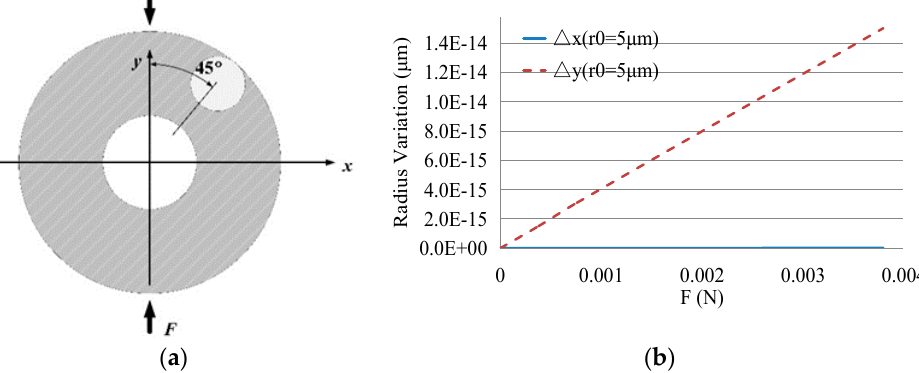
Figure 15. ( a ) A simplified model about cross-axis coupling in disk resonator. ( b ) The comparison of cross-axis coupling signal and drive signal.